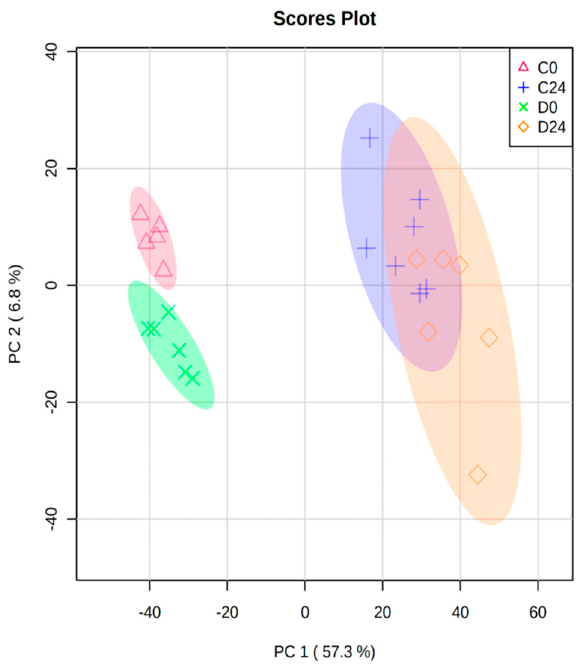
Figure 1. Principal Component Analysis (PCA) biplot of all normalized samples ( n = 24) from the 4 groups (C0: control samples at 0 h; C24: control samples at 24 h; D0: diabetic samples at 0 h; D24: diabetic samples at 24 h). Circles show 95% confidence.